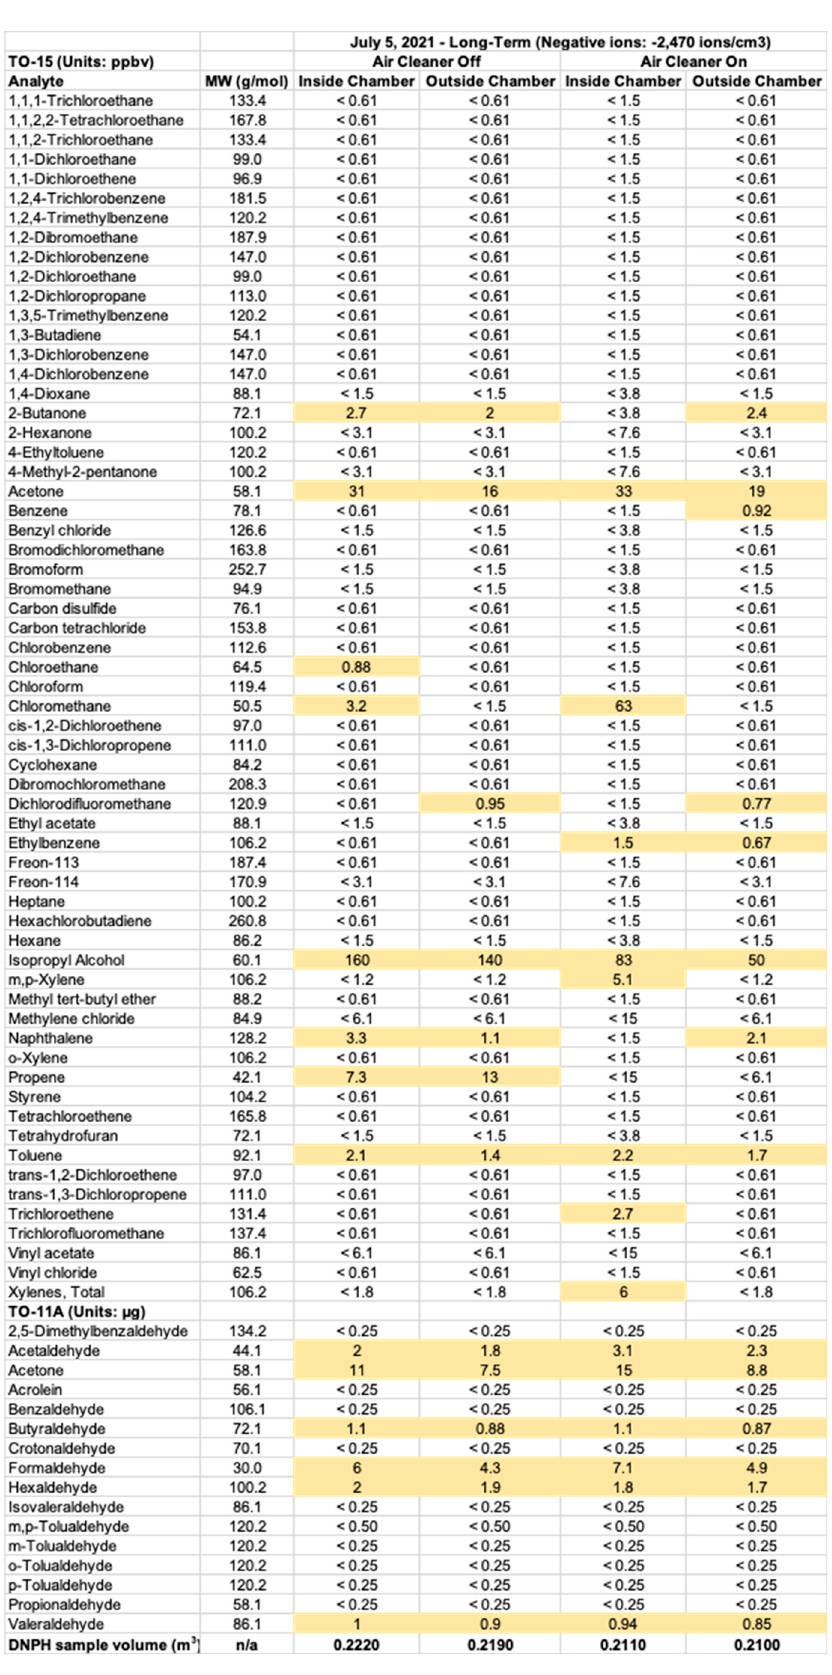
Figure A3. TO-15/TO-11A analytes and reported concentrations: 5 July 2021 long-term test.